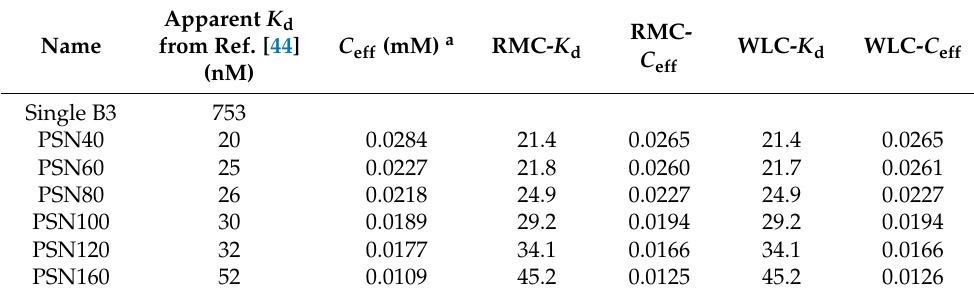
Table 1. The fitting results of WLC and RMC with experimental data.